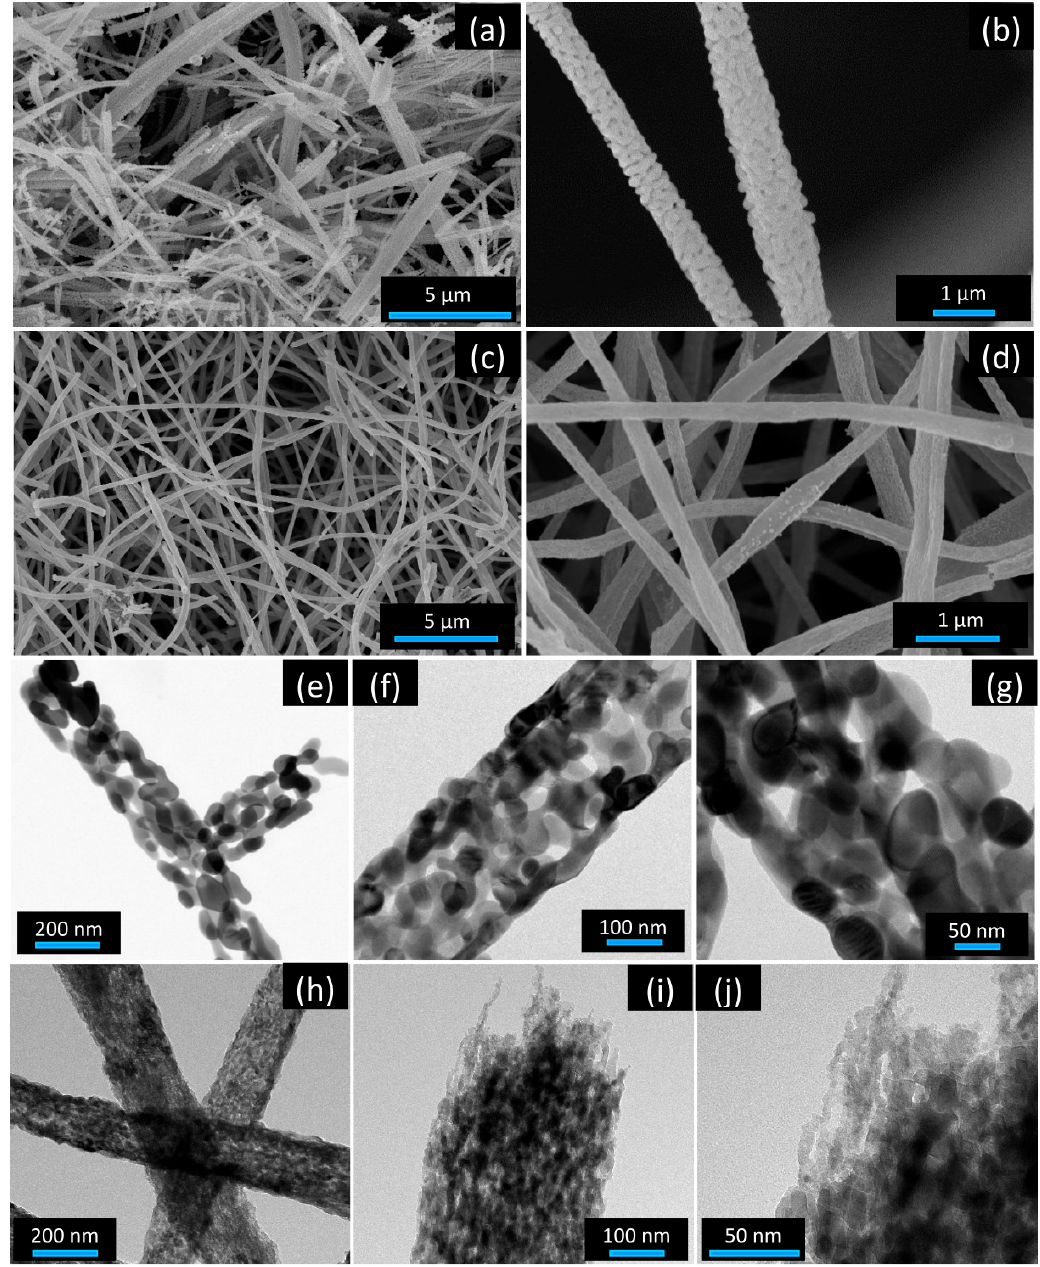
Figure 1. Morphology of the electrospun NFs, as resulting from ( a – d ) SEM and ( e – j ) TEM analyses. The shown SEM images refer to ( a , b ) Fe 2 O 3 NFs and ( c , d ) Fe 2 O 3 :Ge NFs. The shown TEM images refer to ( e–g ) Fe 2 O 3 NFs and ( h–j ) Fe 2 O 3 :Ge